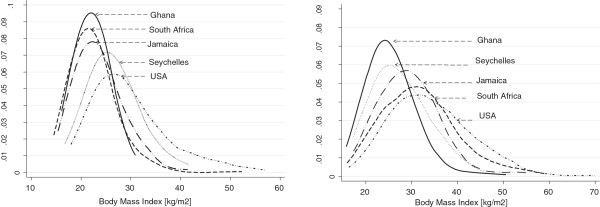
BMI (kg/m
2
) distribution by site for men (left panel) and women (right panel).